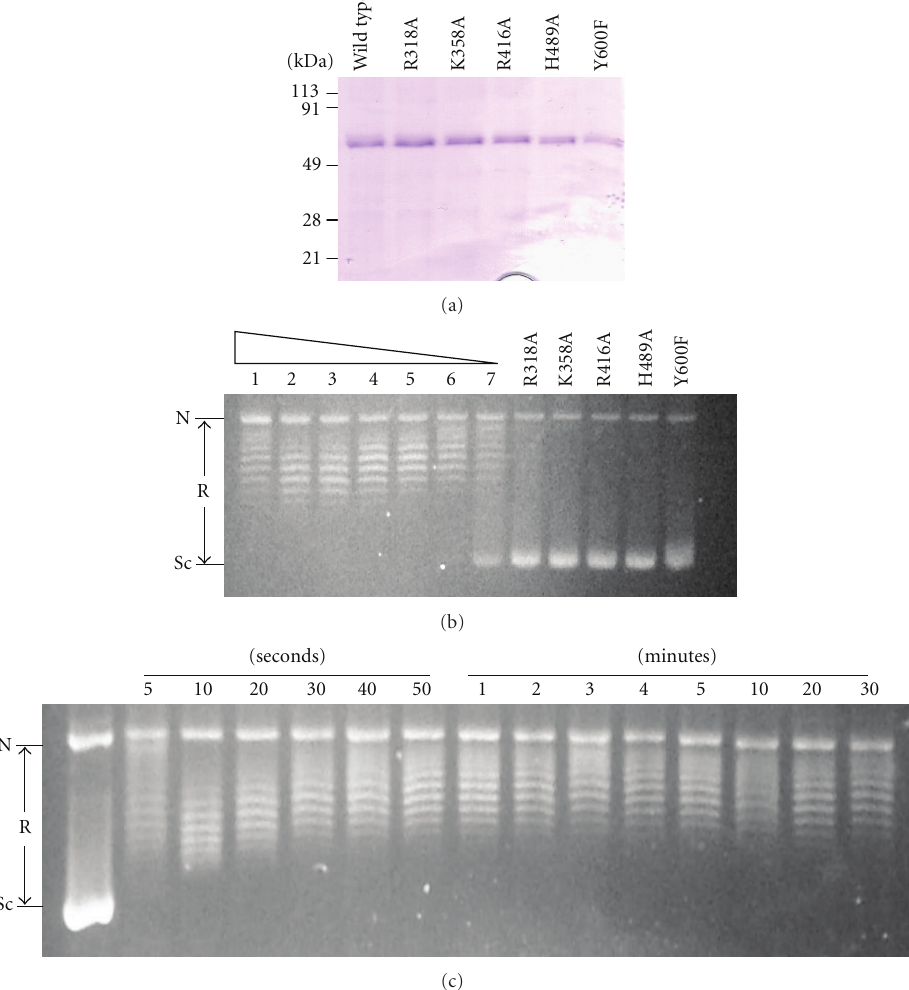
Figure 2: Expression and activity of CpTopIB and mutants into an EKY3 Top-IB-deficient yeast strain. (a) SDS-PAGE from the purified yeast extracts expressing wild type CpTopIB and the point mutations carried out into catalytic tetrad amino acids (R318A, K358A, R416A, and H489A) as well as the active site (Y600F). (b) Dilution assay 2-fold serial dilutions of wild type CpTopIB were assayed in a plasmid DNA relaxation assay for 30 minutes at 37 ◦ C (as described under “Materials and Methods”). (c) Equal concentrations of CpTopIB were incubated stepwise for 10 seconds to 30 minutes in a plasmid DNA relaxation assay. Reaction products were resolved in agarose gel and subsequently visualized by ethidium bromide staining. The reactions were incubated at 30 ◦ C for 30 minutes and then stopped with a mixture of 1% SDS and 6.1 μ g of proteinase K. The reaction products were resolved in a 1% agarose gel and visualized by ethidium bromide staining. N: nicked; Sc: supercoiled DNA, R: relaxed